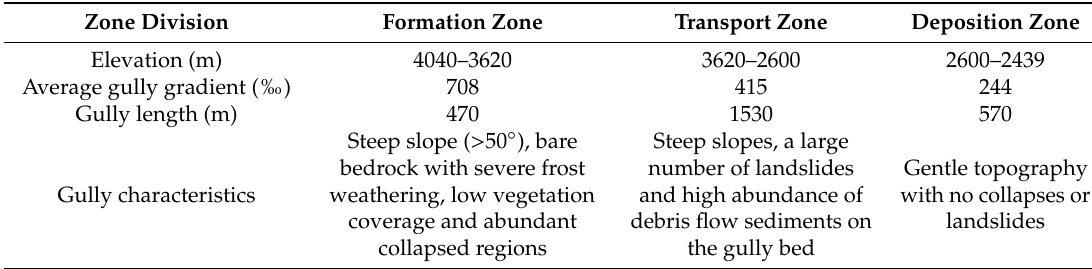
Table 1. Zone division of Zechawa Gully.